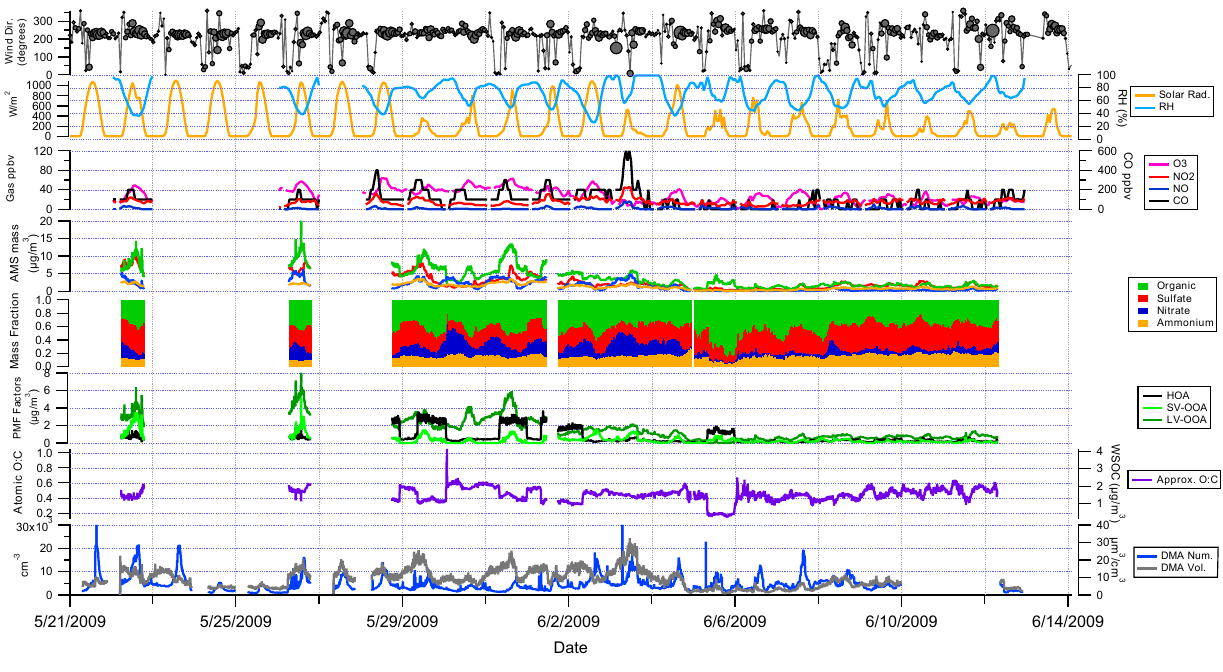
Fig. 1a. Regime I (wind direction marker size proportional to wind speed; max size=20kmh − 1 ).